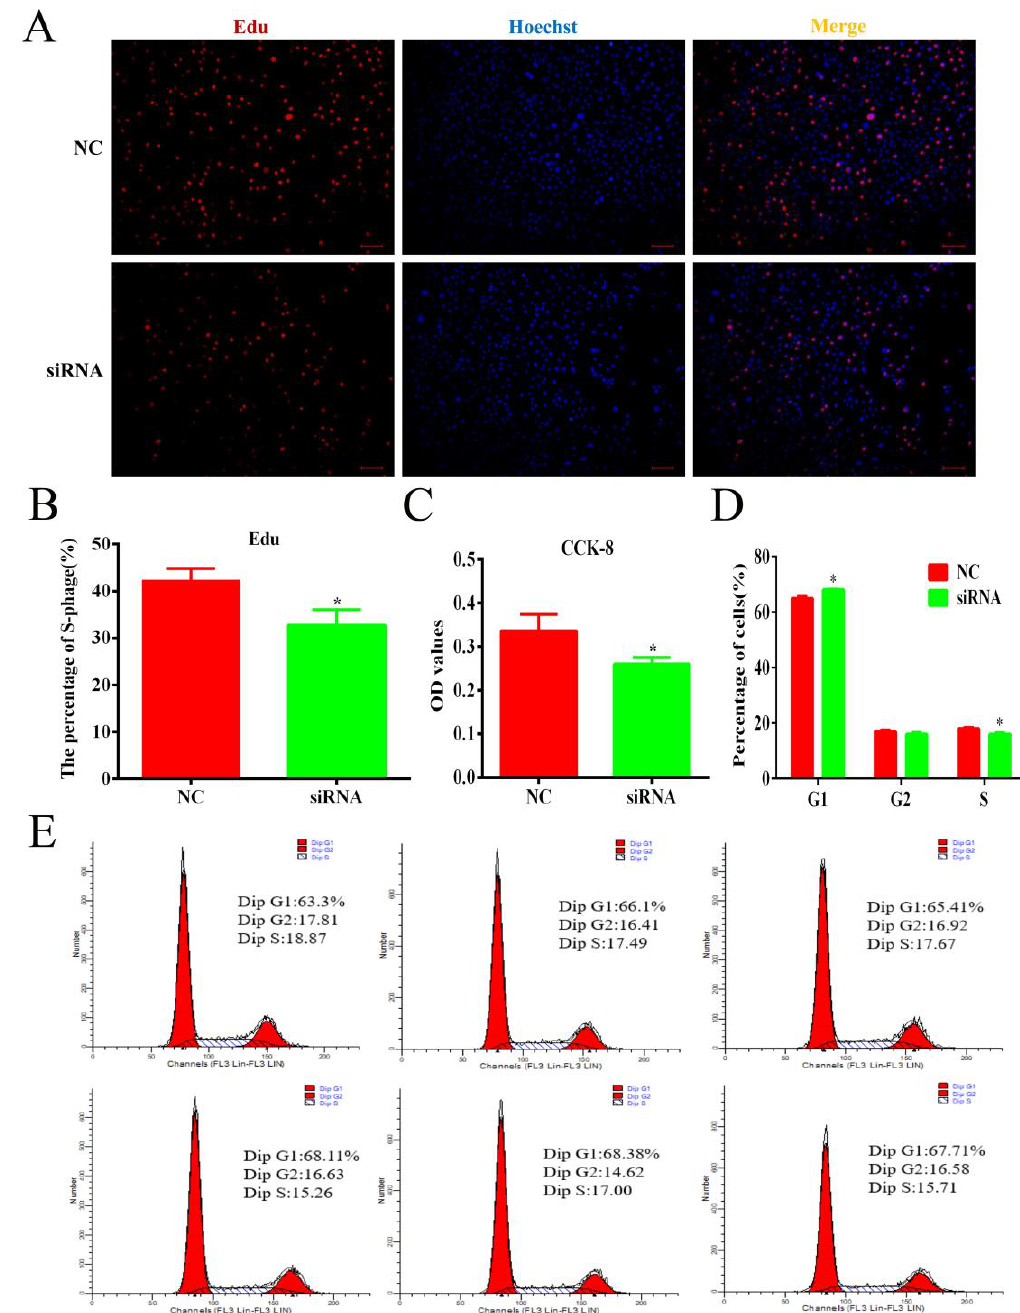
Figure 7. Knockdown of lnc-ORA inhibits cell proliferation and decreases the number of total cells as well as of S-phase cells. ( A ) Edu staining analysis of preadipocytes. Preadipocytes in the S-phase were stained with Edu in red, while the cell nuclei were dyed with Hoechst in blue. ( B ) Percentage of Edu-positive cells vs. total cells. ( C ) CCK-8 analysis after treatment with siRNA during preadipocyte proliferation. ( D ) Statistical analysis of flow cytometry data. ( E ) Flow cytometry analysis of preadipocytes. Data are expressed as the mean ± SEM (n = 3). * p < 0.05, vs. NC.